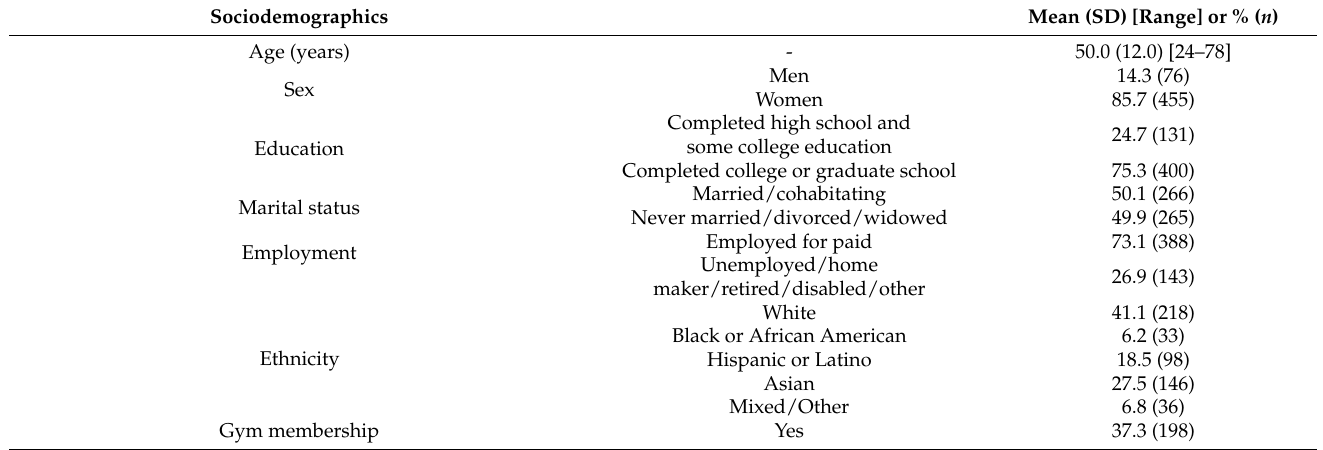
Table 1. Sociodemographics, cardiovascular risk factors, self-monitoring behaviors, weight, height, and body mass index (BMI) of the sample ( n =